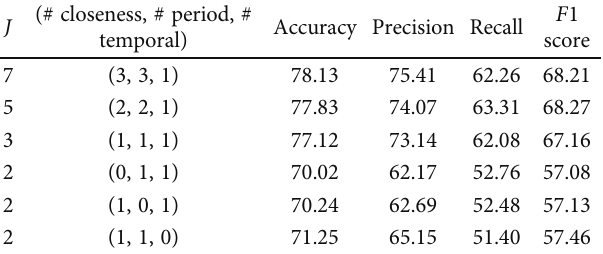
Table 5: E ff ects of time combinations.